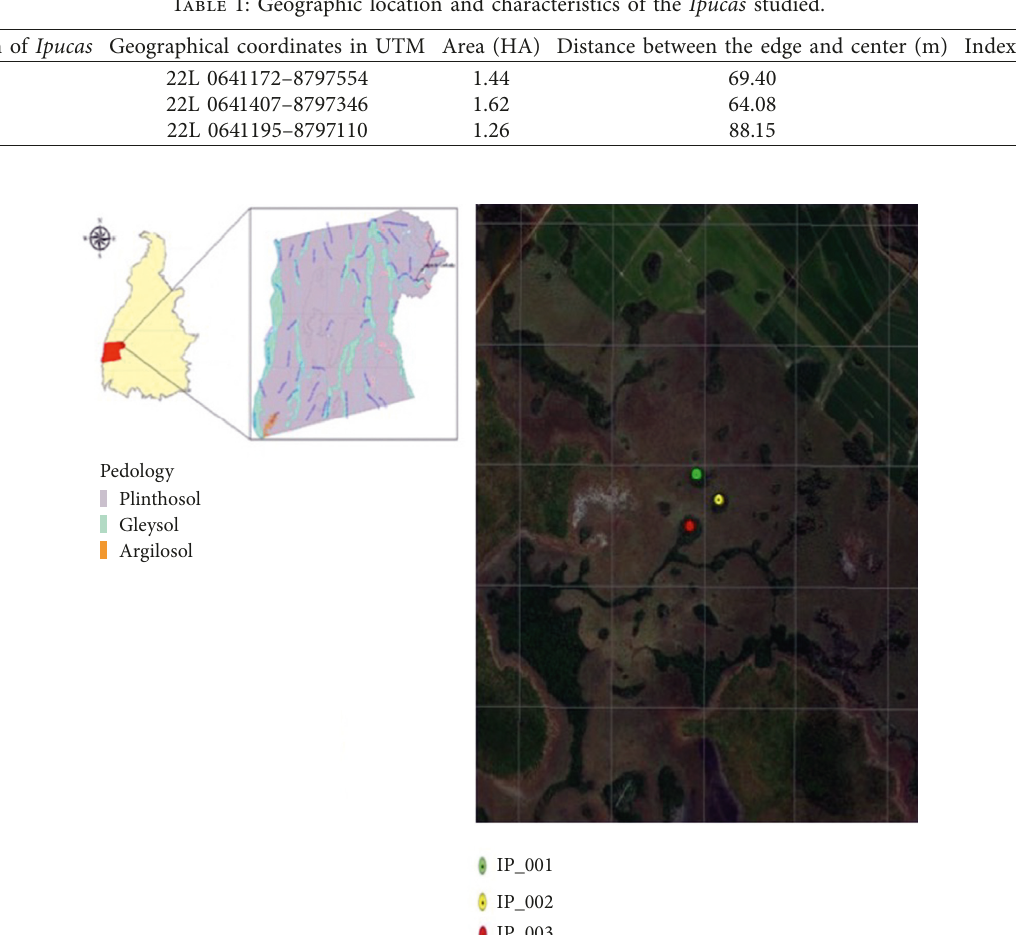
Figure 1: Map of the location of Ipucas studied in the municipality of Lagoa da Confusão, Tocantins,